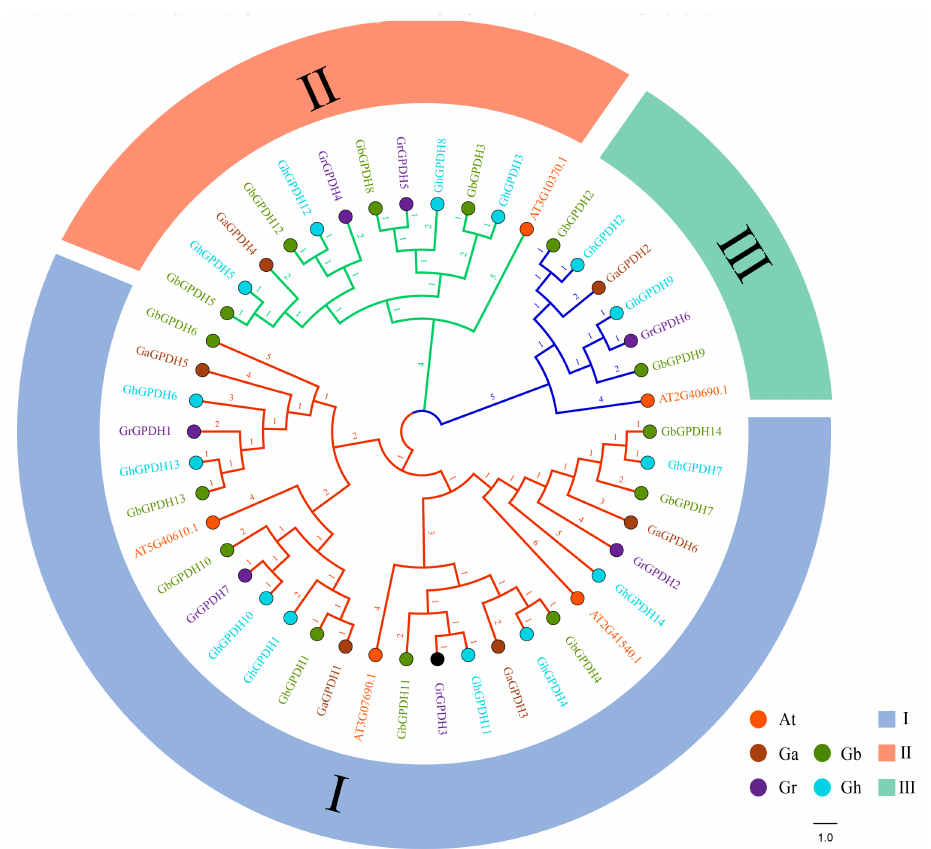
Figure 4. Phylogenetic tree of GPDH family members in cotton and Arabidopsis . At, Ga, Gb, Gh and Gr are represented by circles that are filled with orange, brown, green, blue and purple, respectively. Light purple, light orange and light green were used to distinguish the three groups. The branch label shows time which is scaled by a factor of